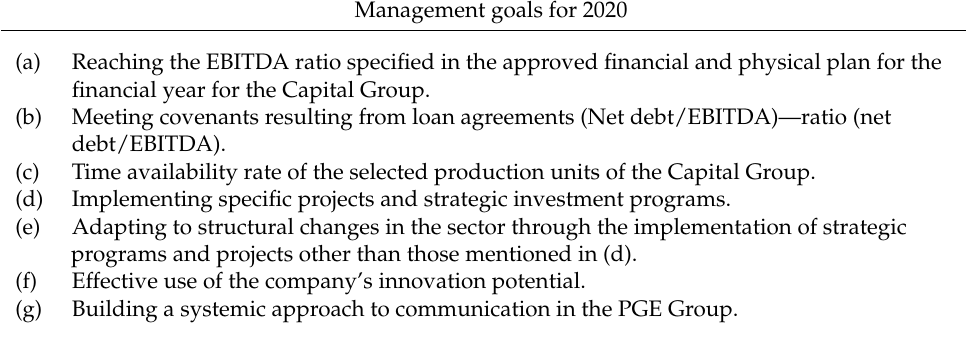
Table 5. Management goals of PGE Polska Grupa Energetyczna S.A. for